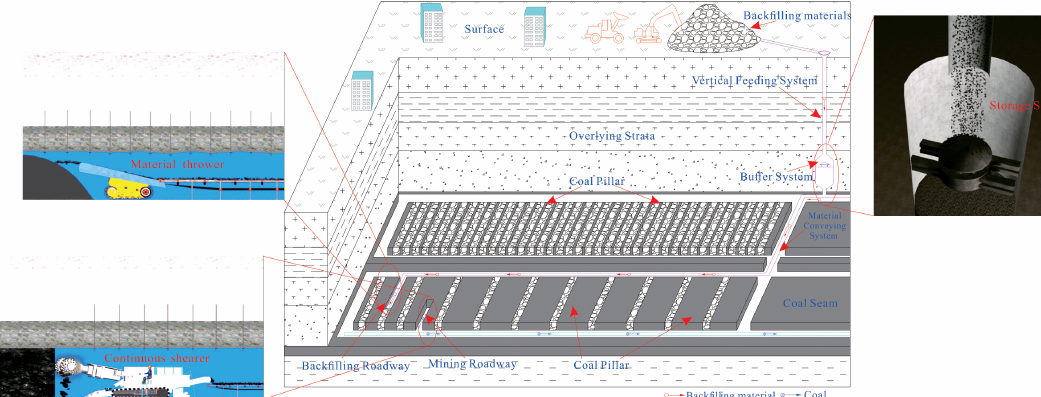
Figure 6. Principle of roadway driving with backfill technique.